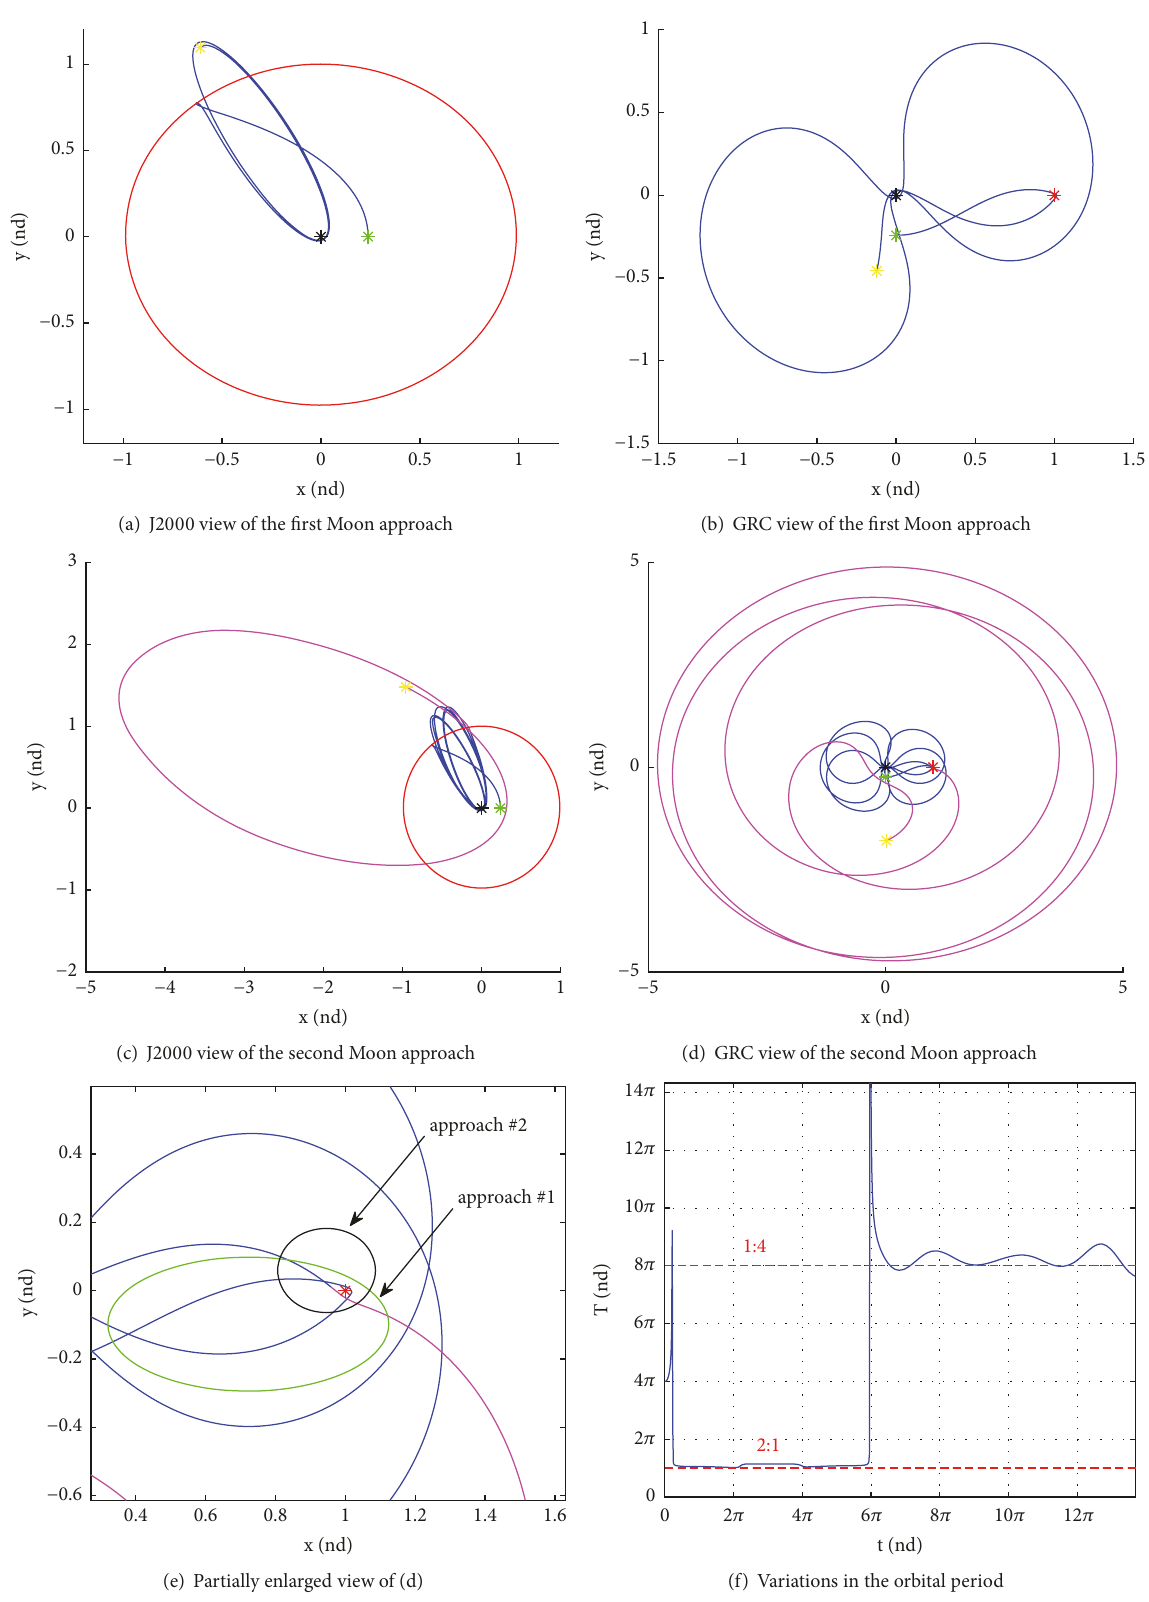
Figure 9: Resonance transition and weak capture by the Moon in the 1:2 resonant orbit with e = 0.85, 𝜃 0 = 90 ∘